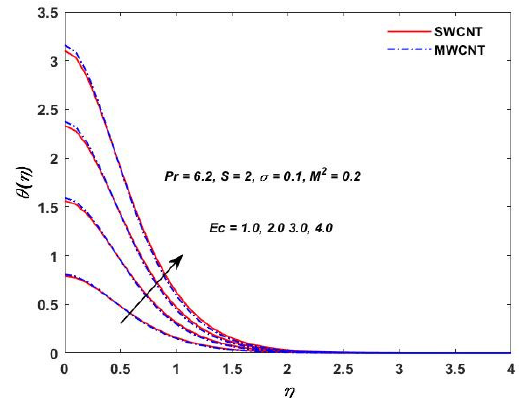
Figure 12. 𝐸𝑐𝑘𝑒𝑟𝑡 verses 𝜃𝜂 .